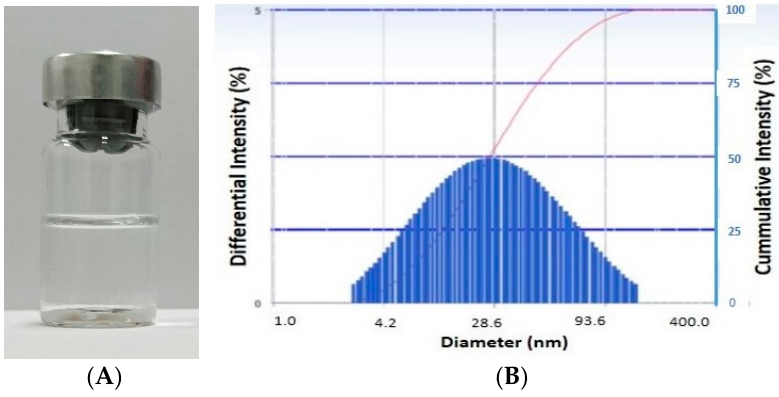
Figure 2. Visual appearance ( A ) and globule size distribution ( B ) of blank nanoemulsion after nine months storage at room temperature.